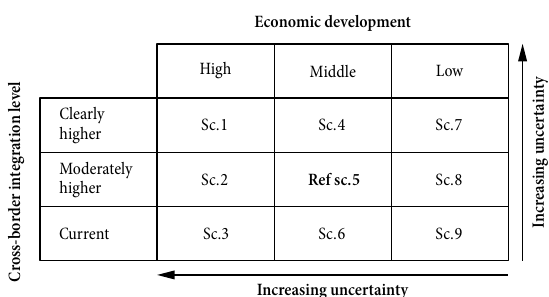
Fig. 6. Scenario-grid for imagined futures for the HH-Connec- tion project (adapted from Salling, Leleur